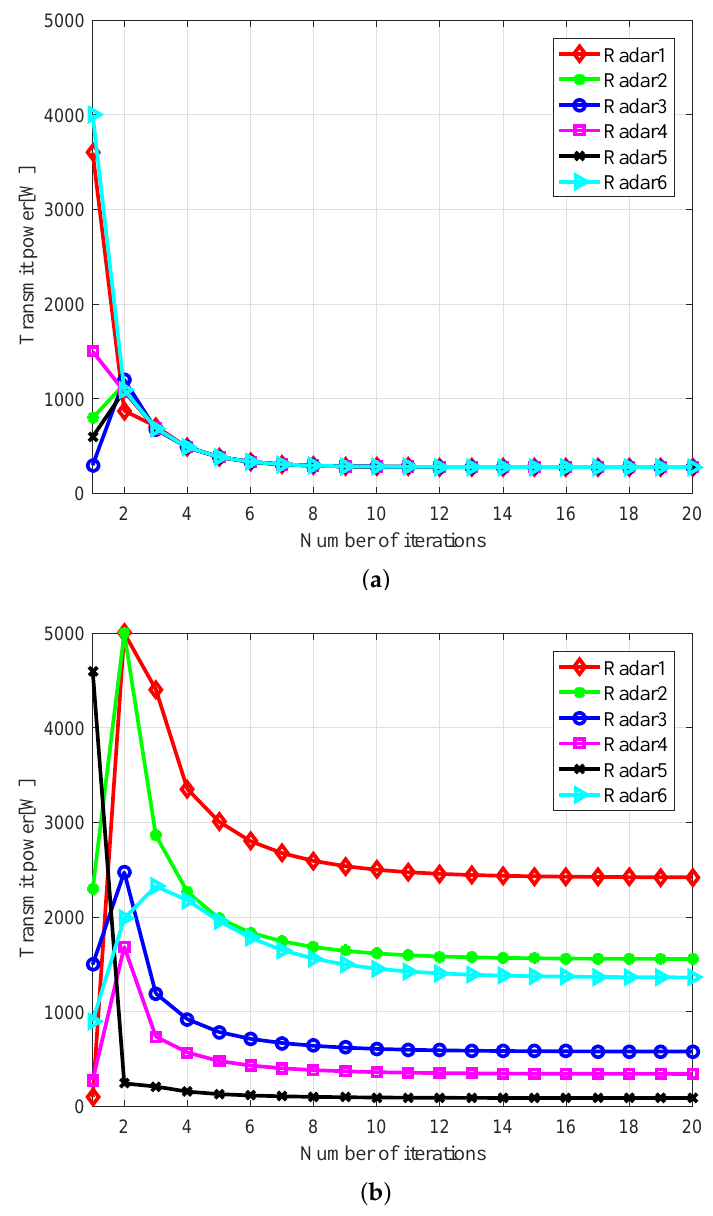
Figure 2. Convergence behavior for the transmit power of each radar in the first case: ( a ) Target position is [ 0,0 ] km; ( b ) Target position is [ − 30, − 40 ]